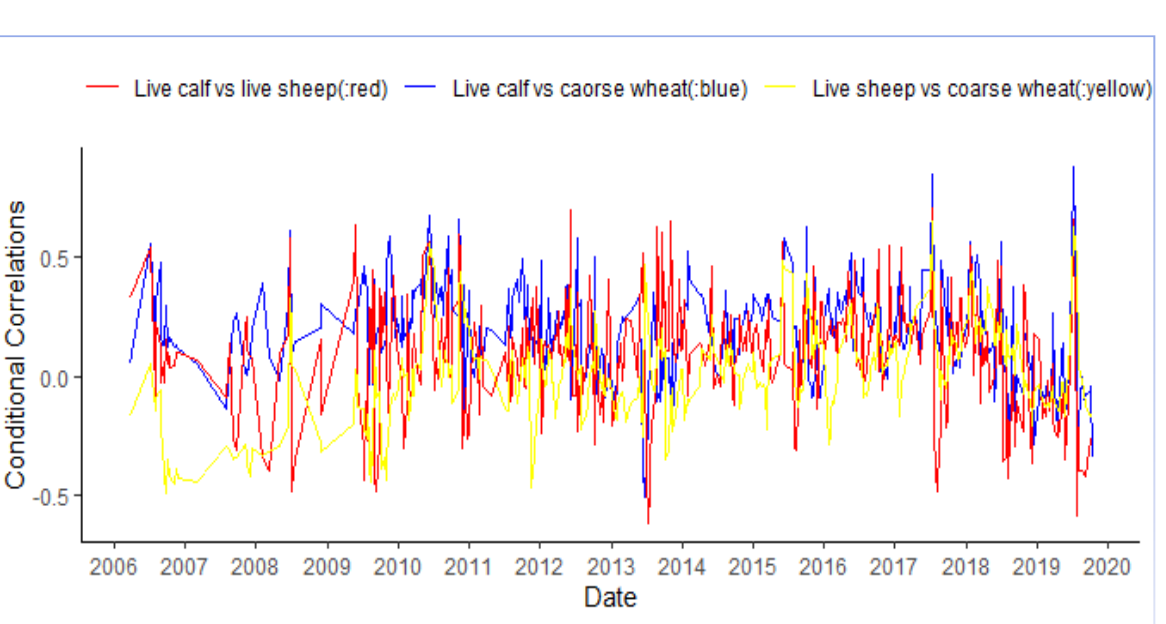
Figure 5. Time-varying conditional correlation between live calves, live sheep, and coarse wheat.